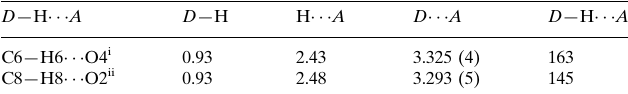
Hydrogen-bond geometry (A˚ , (cid:1)